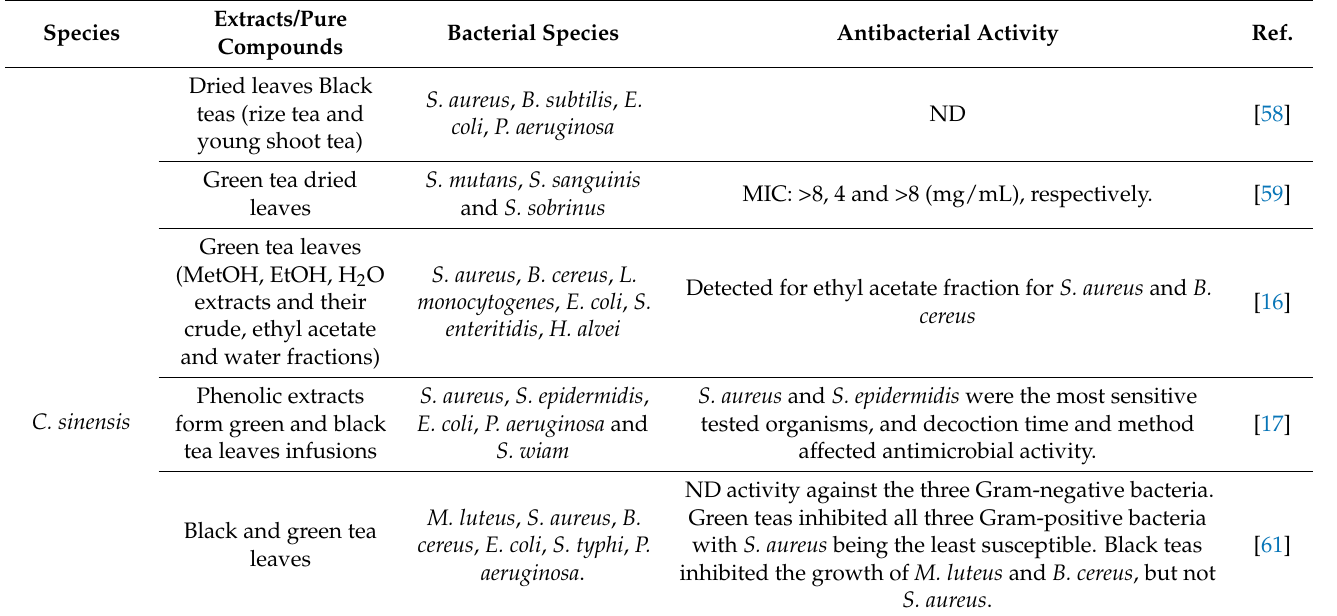
Table 2. Antibacterial activity of Camellia